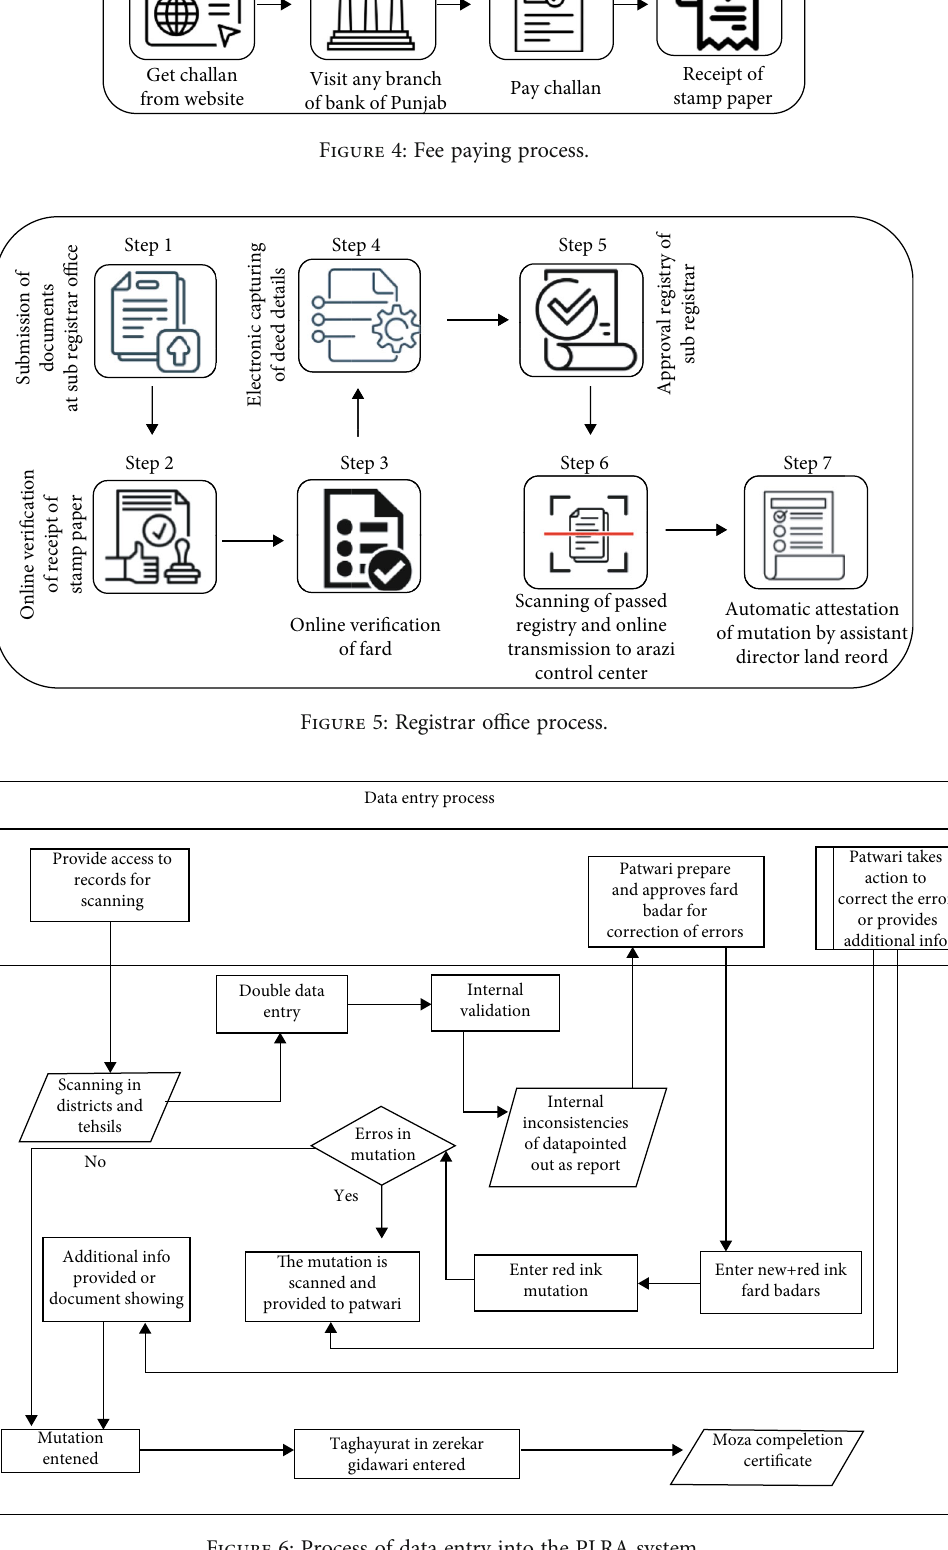
Figure 6: Process of data entry into the PLRA